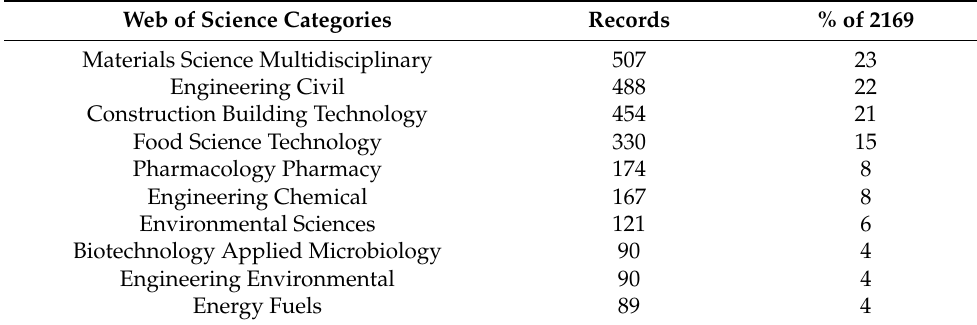
Table 3. Number of results divided in subject area for the keyword